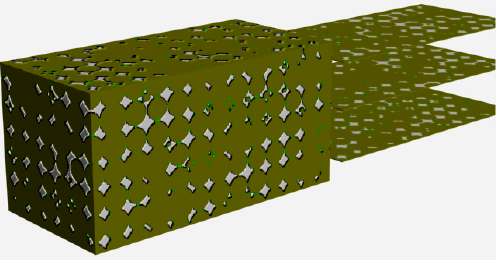
Figure 12. Three-dimensional simplified model diagram of core 69 # ( α s = 0.75).